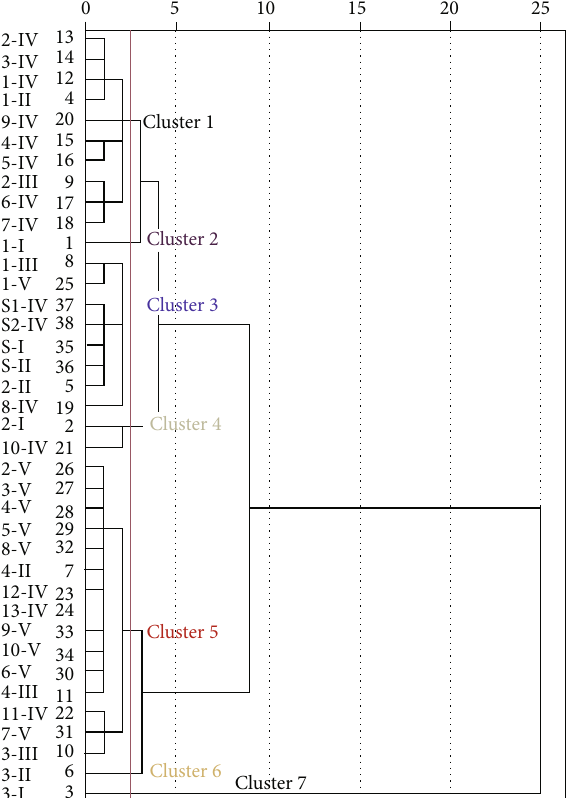
Figure 9: Sample clustering